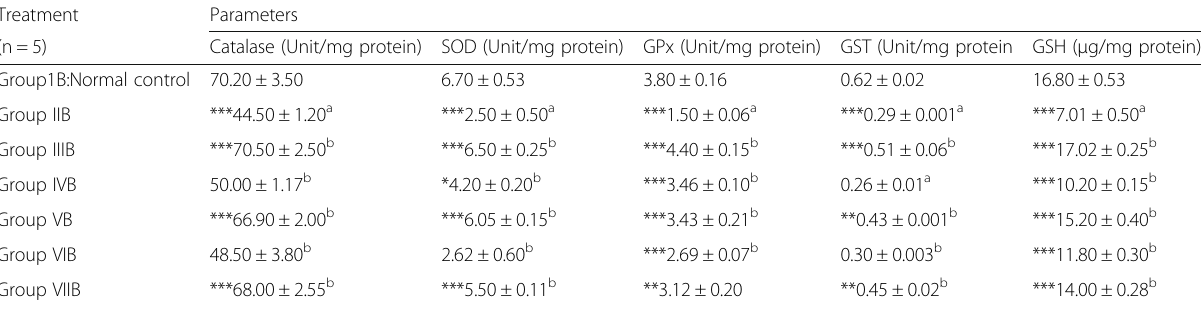
Table 2 Effect of methanol extract of T. conophorum seeds on Liver Antioxidant Status in CCl 4 induced hepatotoxicity in rats after 48 h of intoxication Catalase (Unit/mg protein) SOD (Unit/mg protein) GPx (Unit/mg protein) GST (Unit/mg protein GSH ( μ g/mg protein)